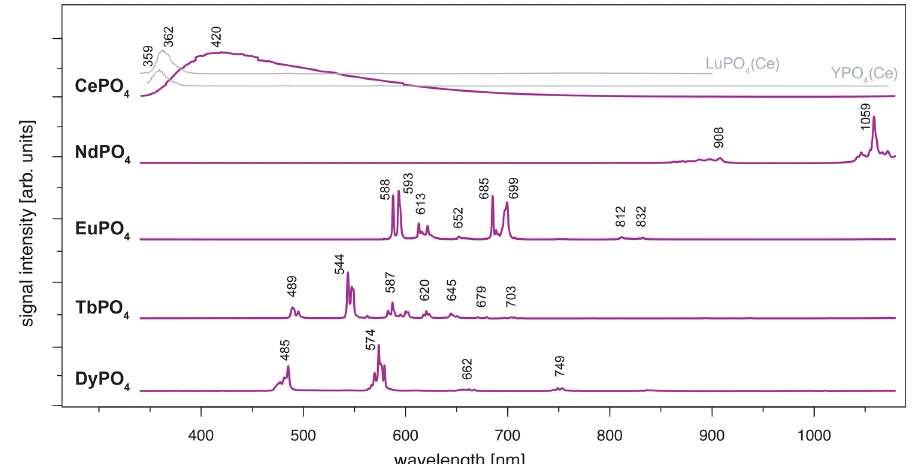
Figure 4. LiF reference spectra obtained with 325nm laser excitation depict the diagnostic emission lines for the REE phosphates NdPO 4 , EuPO 4 , TbPO 4 and DyPO 4 (given values represent wavelength of most intense emission in nanometres for each transition; cf. Table 2). CePO 4 is included for completeness, and diagnostic emissions are shown by the grey lines representing spectra from two non-luminescent REE PO 4 samples with cerium contaminations (see further explanation in the text along with cerium concentrations in those samples based on neutron activation analysis, NAA,